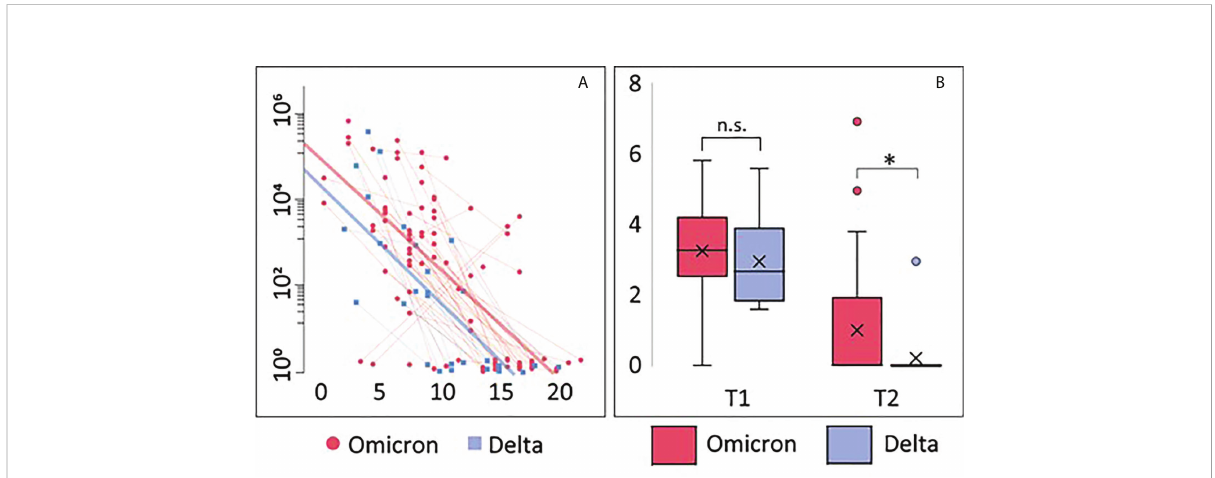
FIGURE 1 Viral load. (A) Correlation between viral load and days after symptom onset during the observation period. Thin blue/red lines represent paired samples while thick blue/red lines represent regression curves for the whole group (Omicron or Delta). (B) Viral load shown as Tukey-plots at inclusion (T1) and one week follow-up (T2) according to infection with Omicron or Delta. Differences in viral load at T1 and T2 were compared by ANCOVA, adjusting for symptom days: *p<0.05. ns, not signi fi